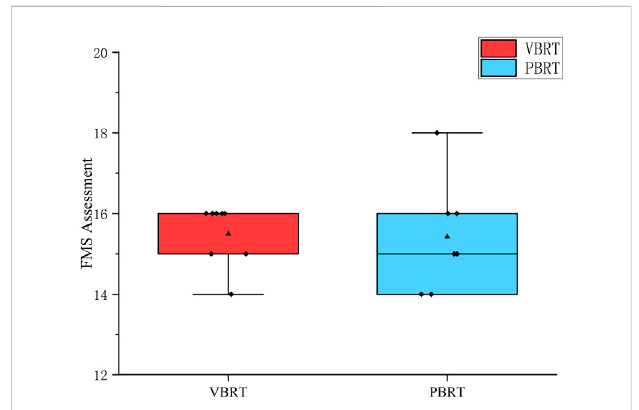
FIGURE 4 Baseline FMS assessment. FMS test indicates functional movement